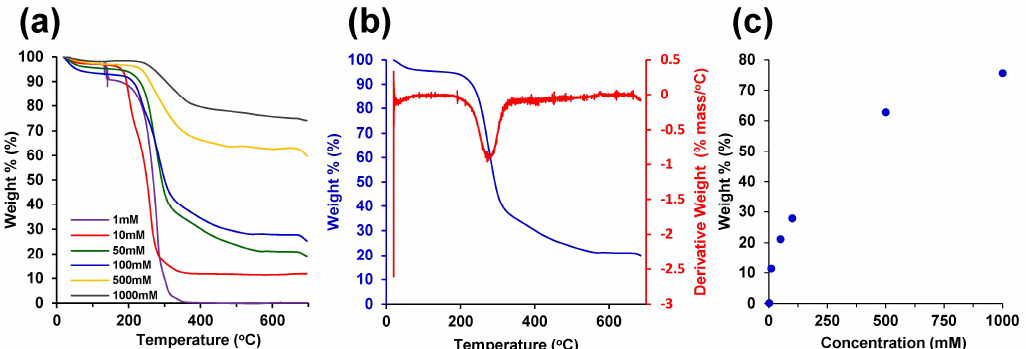
Figure 5. Thermogravimetric analysis (TGA). ( a ) TGA of aerogels synthesized with Pd(NH 3 ) 4 Cl 2 salt solutions; ( b ) TGA of 50 mM Pd(NH 3 ) 4 Cl 2 sample from ( a ) with differential thermal analysis (DTA); ( c ) palladium sample mass at 600 °C from ( a ) for the varying palladium concentrations.